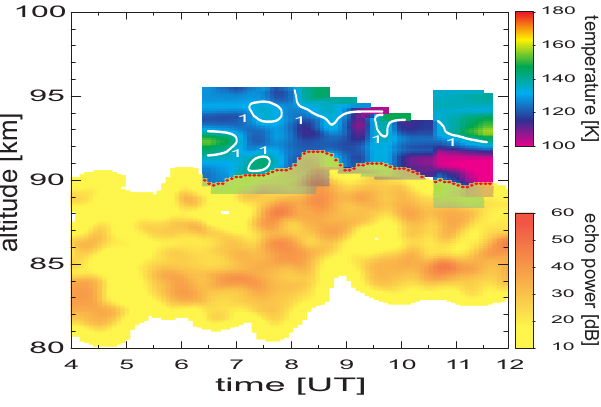
Fig. 1. Simultaneous measured temperature and PMSE over Spitzbergen on 6 July 2003. The frost point temperature (with- out freeze-drying-effect) is indicated by the white line by using the model of von Zahn and Berger (2003). The red dots show the top side of PMSE which is the region ( 1 z ± 200m) where temperatures inside PMSE are taken.